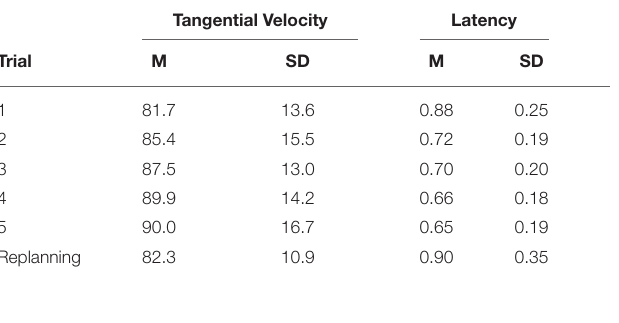
TABLE 2 | Means (M) and Standard Deviations (SD) of tangential velocity and latency in sec by trials.